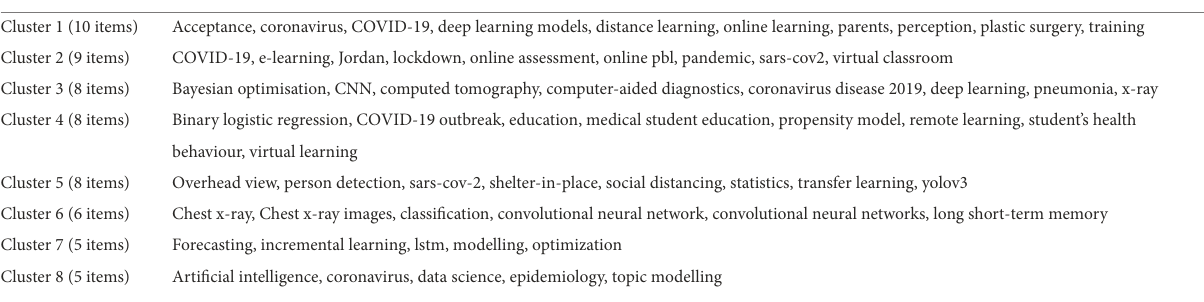
TABLE 3 Learning strategies and models in COVID-19 depending on Science Direct (VOSviewer outputs).